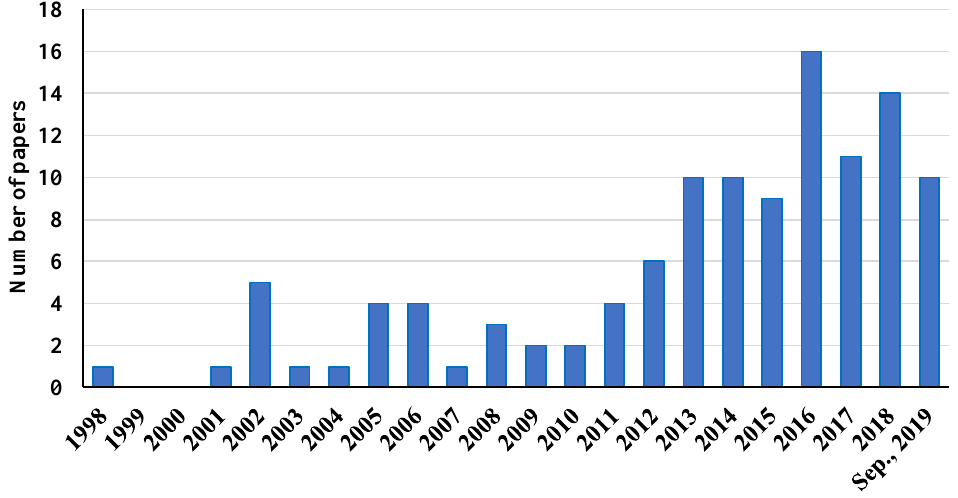
Figure 2. Number of included manuscripts by publishing date .